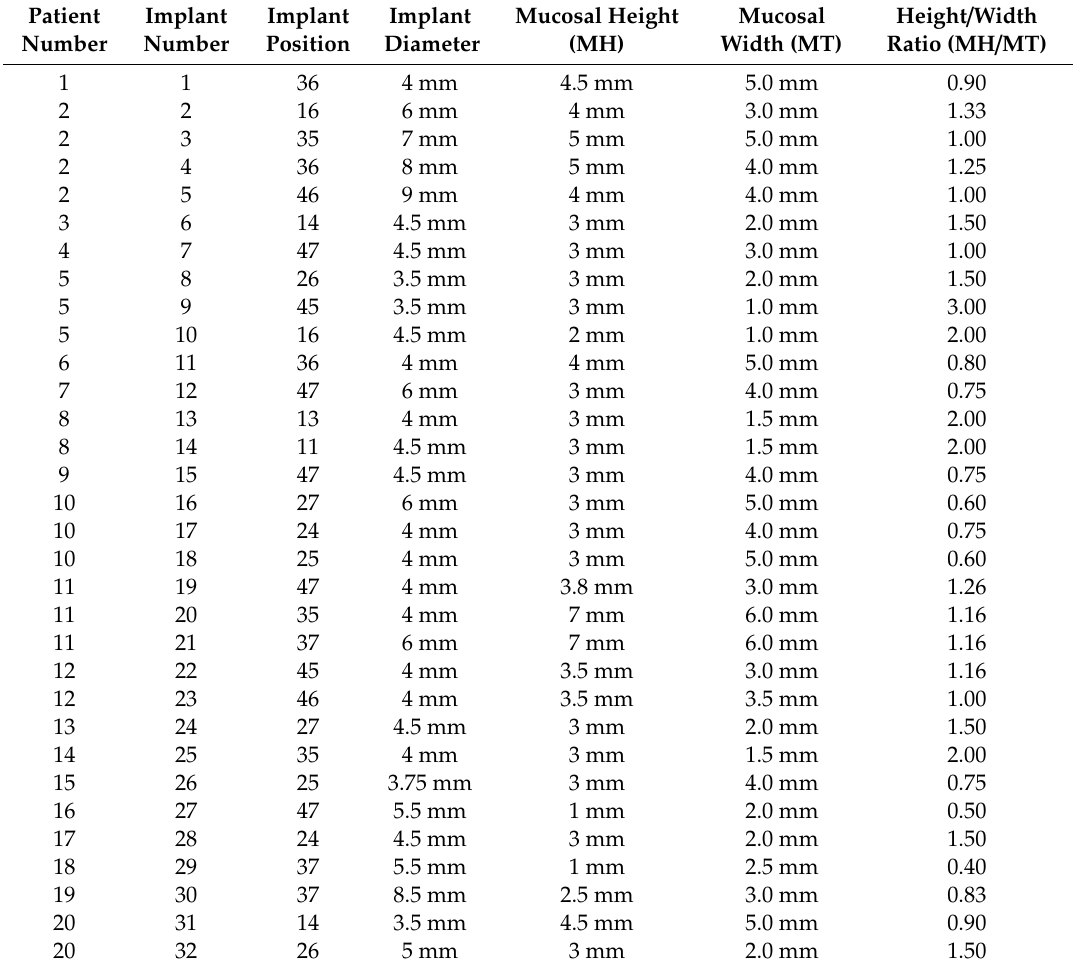
Table 1. Individual measurements of mucosal height (MH), mucosal width (MT) and their ratio (MH /